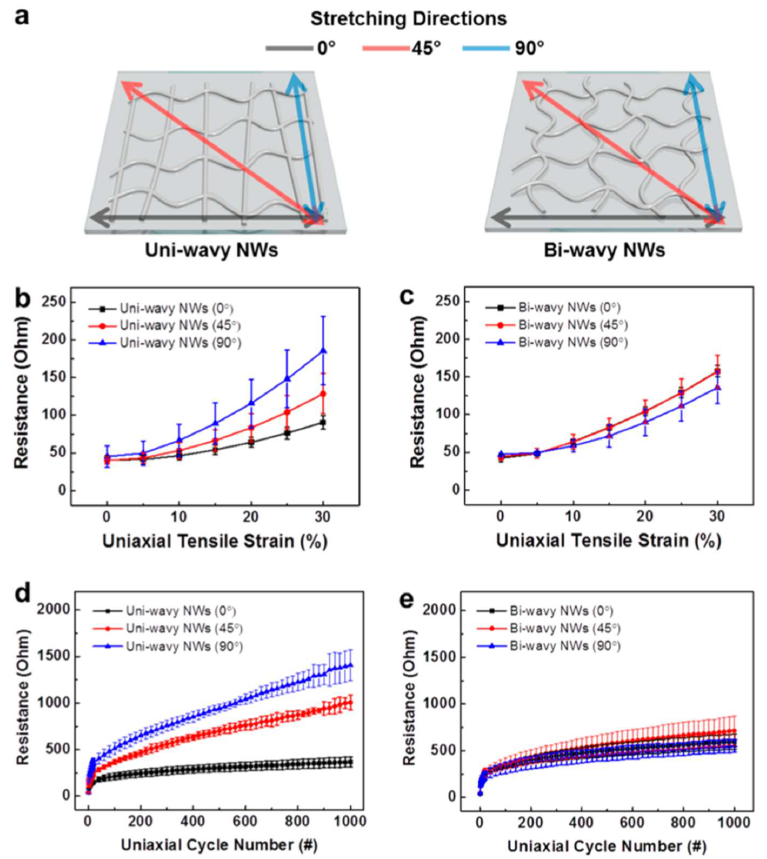
Figure 6. ( a ) Schematics showing the stretching directions of the uniaxial tensile strains for uniwavy NWs and biwavy NWs. Resistance changes as a function of the applied uniaxial tensile strain for ( b ) uniwavy NWs and ( c ) biwavy NWs. Resistance changes as a function of the uniaxial cyclic strain for ( d ) uniwavy NWs and ( e ) biwavy NWs. Electrodes were repeatedly stretched to 30% and released back to 0%. Reprinted from [55], with permission from American Chemical Society, 2017.